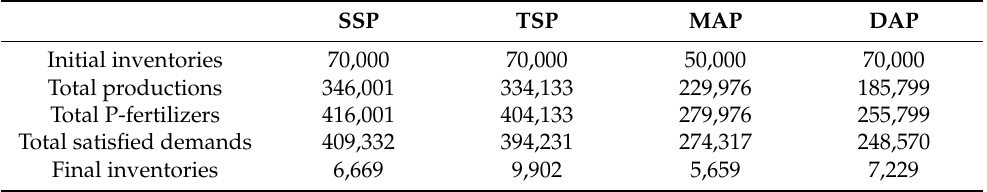
Table 13. Distribution of the different P-fertilizers (ton) in the system.